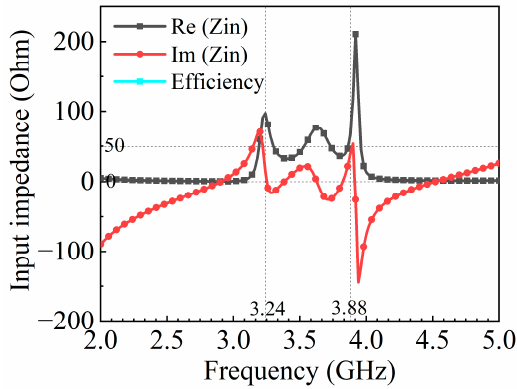
Figure 5. Simulated input impedance plot of the proposed antenna.